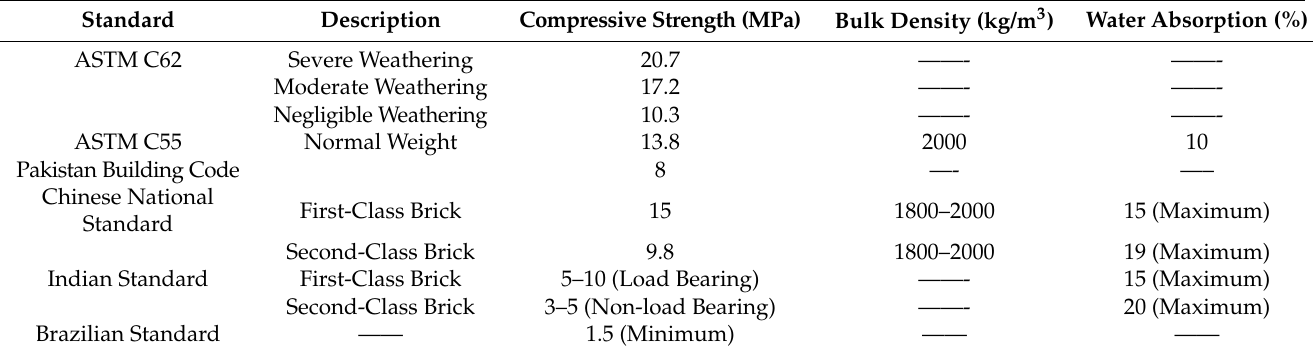
Table 4. The properties specified by the different